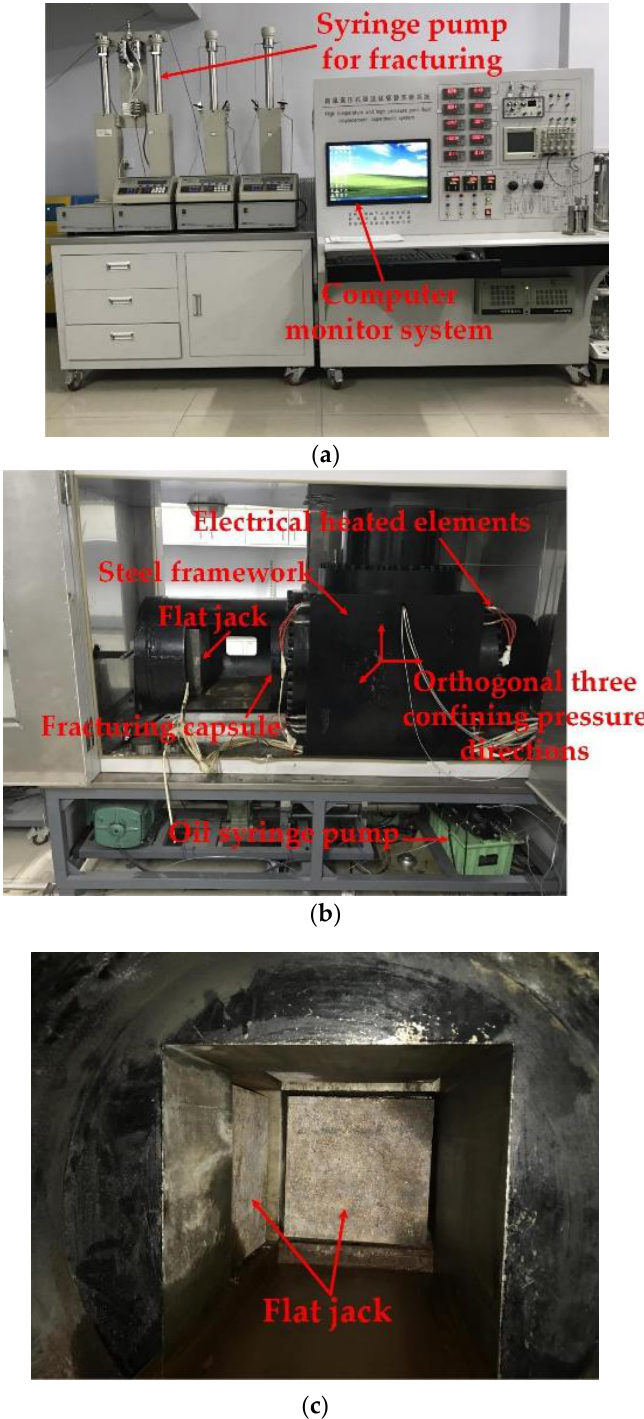
Figure 4. The true-triaxial hydraulic fracturing apparatus: ( a ) the water injection system; ( b ) the steel framework, confining pressure system, and the heating system; ( c ) the fracturing capsule.